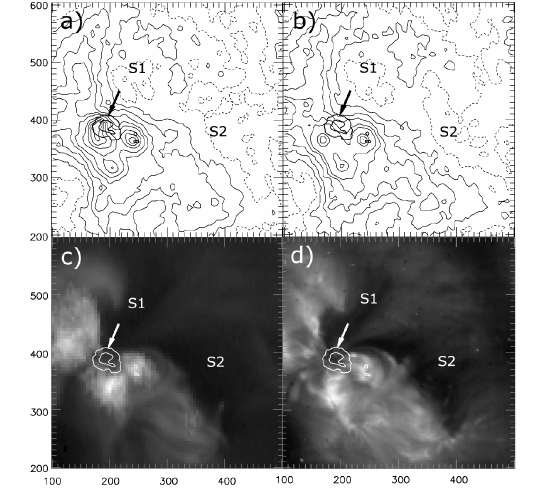
Fig. 3. 1999 May 13 observations of the large sunspot in the AR 8535: (a) the brightness temperature T B x , and (b) T B o contour maps of 17 GHz images (NoRH); (c) the soft X-ray image (Yohkoh/SXT), and (d) the EUV 2.84 × 10 − 8 m image (SOHO